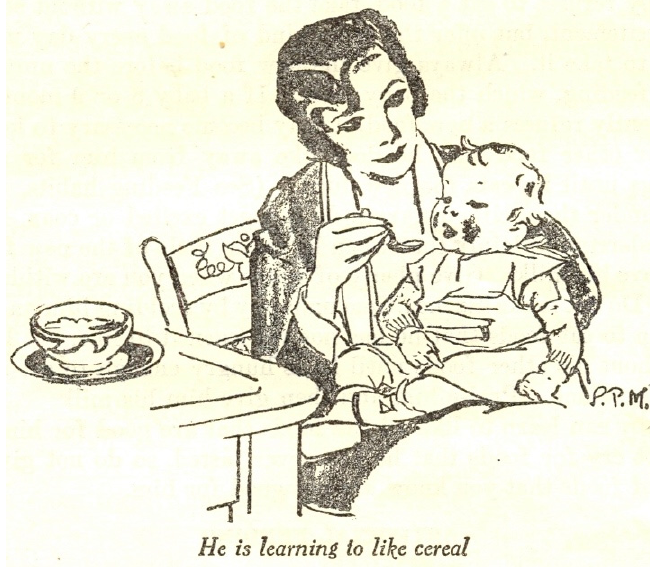
Figure 11. Learning to Like Cereal.